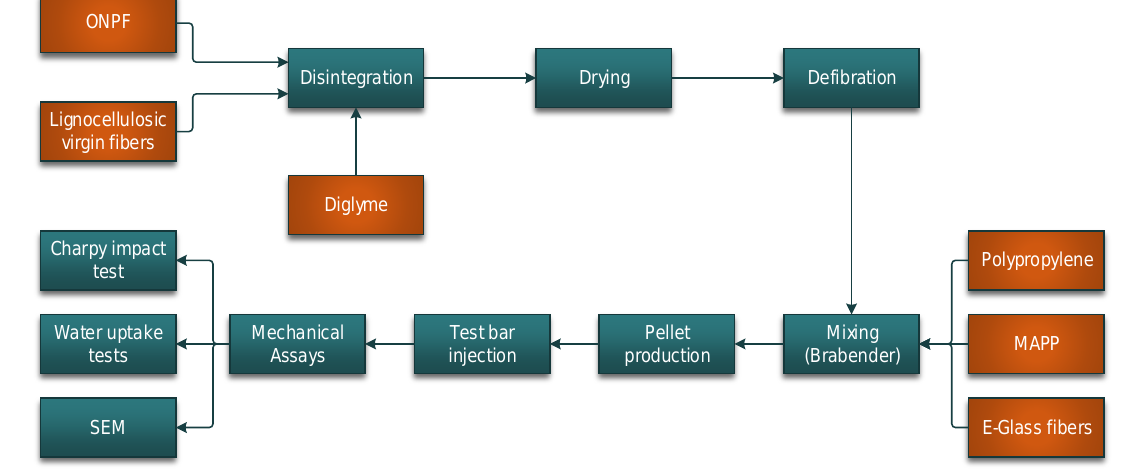
Figure 2. Flowchart of the experimental procedure. 172